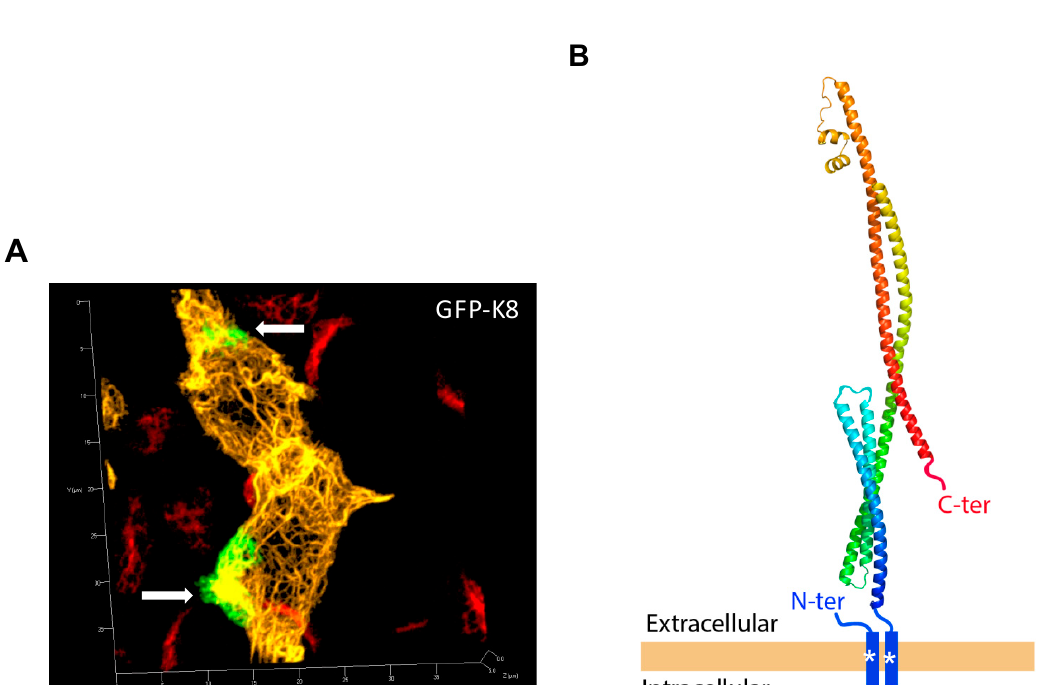
Figure 5. N- and C-terminal parts of eK8 are turned toward the outside of the cell. ( A ) Transfection of HCT116 cells with the GFP-K8 construct and confocal microscopy. Direct visualization of GFP fluorescence (yellow signal) and IF analysis on non-permeabilized cells of GFP (anti-GFP antibody, green signal) and endogenous K8 (M20 antibody, red signal) localization. Three-dimensional (3D) reconstruction of merged images. Externalized GFP-K8 is indicated with white arrows. ( B ) Model of K8 anchorage and topology at the plasma membrane incorporating bioinformatics analyses of K8 structure and transfection experiments of GFP constructs. According to the bioinformatics analysis, alpha helices are represented by different colors (blue, green yellow, and red) and transmembrane domains are indicated with an asterisk